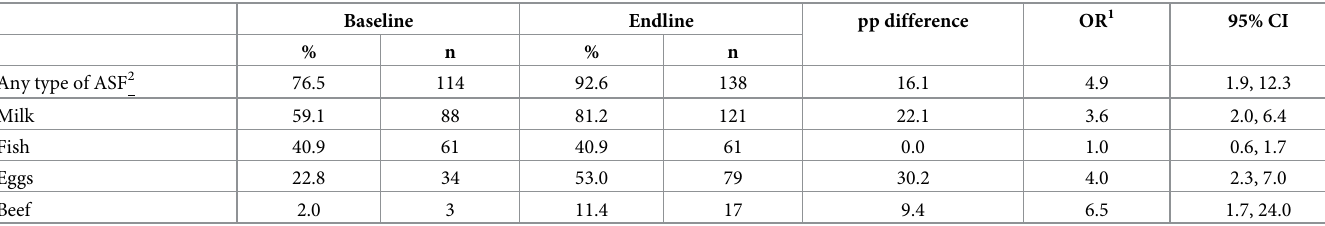
Table 2. Children’s consumption of ASFs two or more times in the last 7 days (N = 149). Baseline